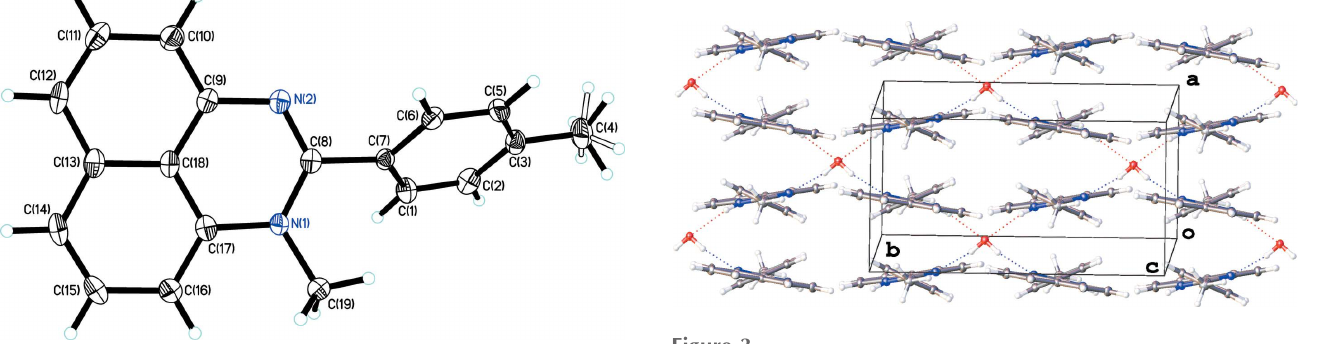
Figure 2 Molecular structure of 1-methyl-2-( p -tolyl)-perimidine ( 2 ), with displace- ment ellipsoids drawn at the 50% probability level.